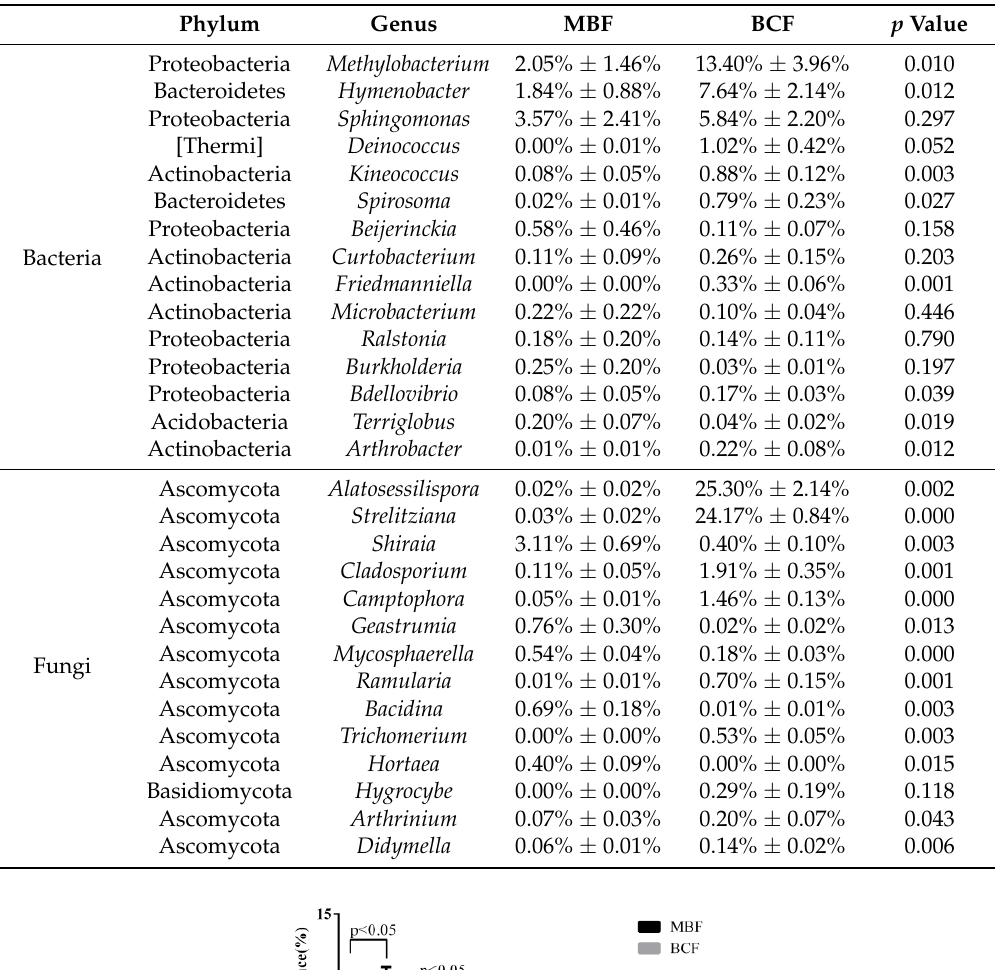
Table 1. Relative abundances of the dominant bacterial and fungal genera in moso bamboo leaves.